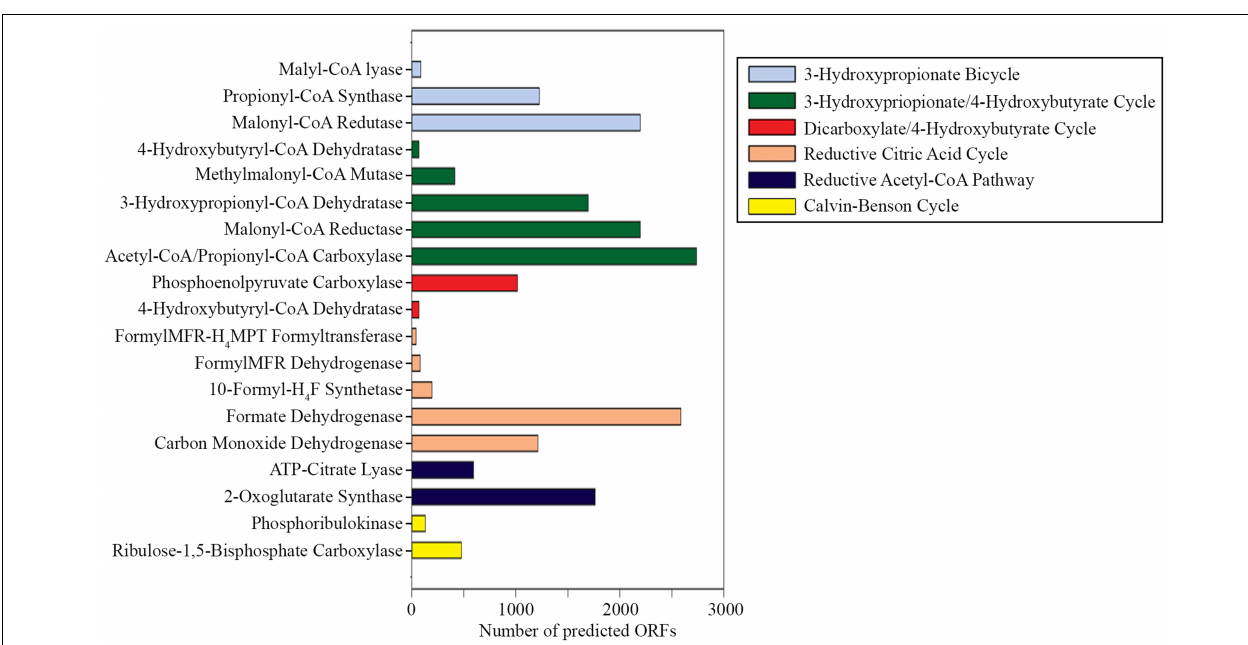
FIGURE 7 | Gene mining for the key enzymes involved in autotrophic carbon fixation. (Abbreviations: FormylMFR-H4MPT formyltransferase, formylmethanofuran-tetrahydromethanopterin formyltransferase; 10-formyl-H4F synthetase, 10-formyl-tetrahydrofolate synthetase).